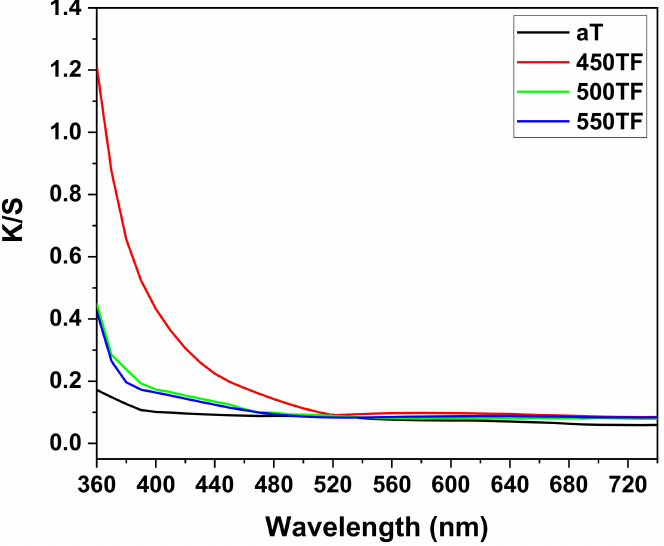
Figure 5. K/S values of fabrics aT, 450TF, 500TF, and